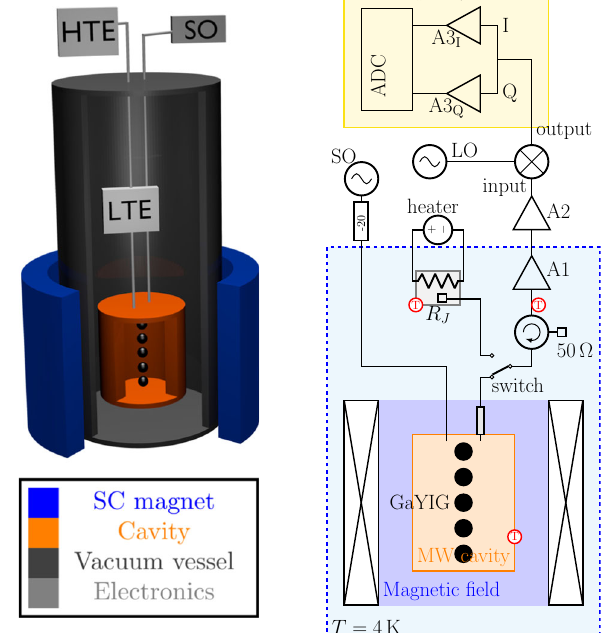
Fig. 4 Left:Simplified scheme (not toscale)of the experimental appa- ratus showing the high temperature and low temperature electronics (HTE and LTE) and the source oscillator (SO). Right: Electronics lay- out.Frombottomtotop,theblue-dashedlineenclosesthecryogenicpart oftheapparatus,thecrossedrectanglesrepresentthemagnet,theorange rectangle is the cavity with black spheres inside standing for the ferri- magnetic material. At the top of the cavity are located the sub-critical antenna (left) and the variably-coupled antenna (right). The sub-critical antenna is connected with a room temperature attenuator and then to the source oscillator SO, while the other antenna is connected to one of the switch inputs. The other input is the 50 Ω resistor R J , and the gray rectangle is the plate where R J is placed and that can be heated with a current generator. The output of the switch is connected to an isolator and then to the A1 and A2 amplifiers. The rf coming from A2 is down- convertedbymixingitwithalocaloscillatorLO.Thetwooutputs,phase I and quadrature Q , are fed into the low frequency amplifiers A3 I